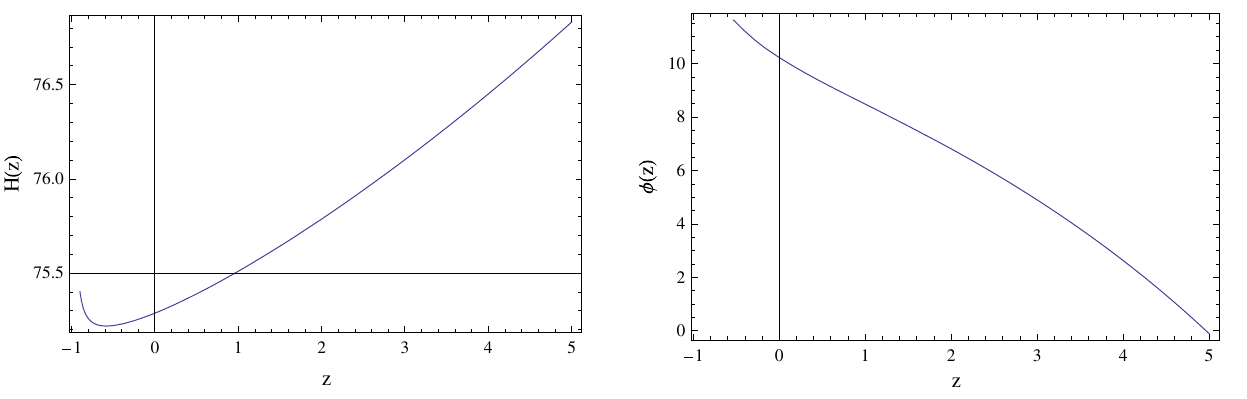
field φ have been drawn in Figs. 15 and 16 respectively.